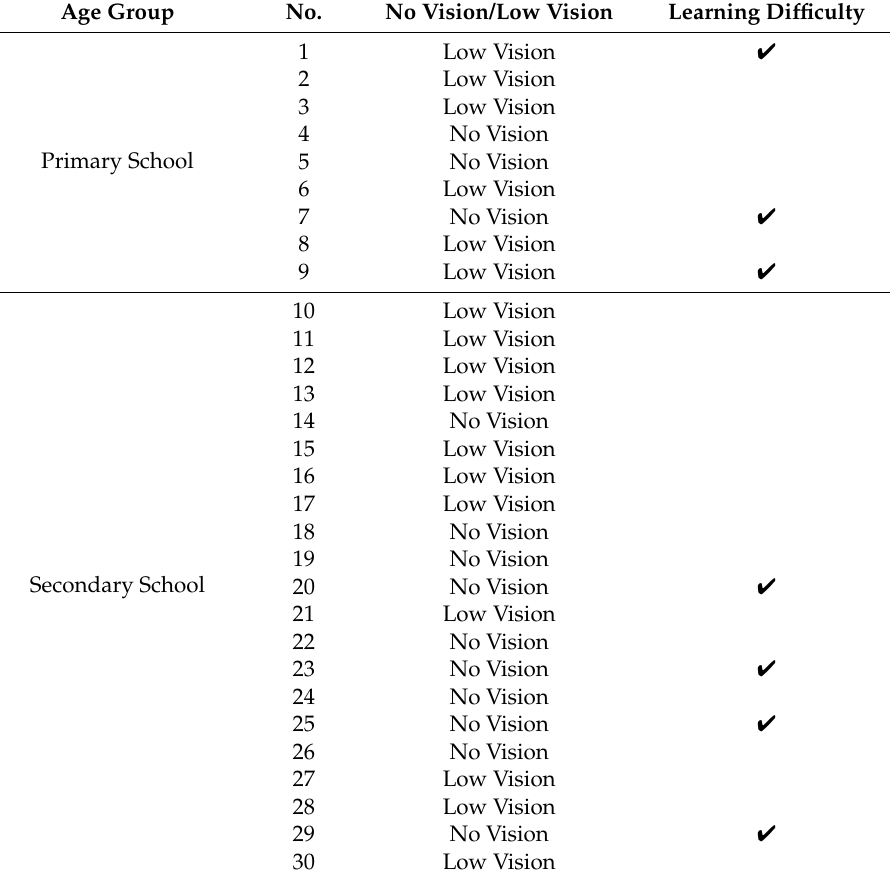
Table 1. Participant